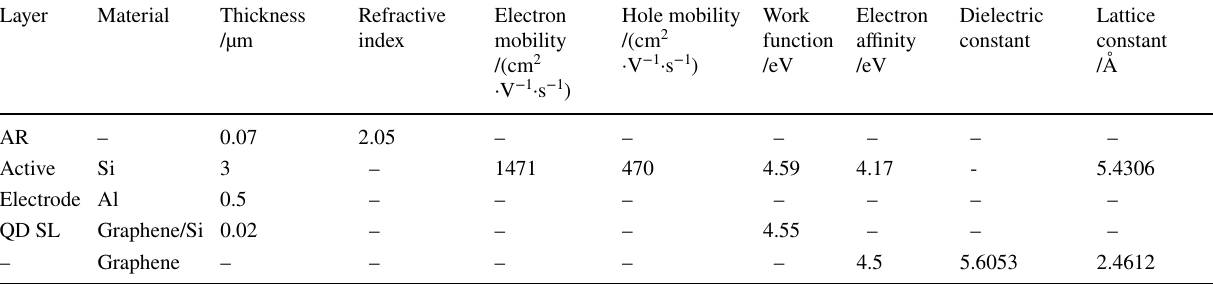
Table 1 Model geometry and material parameters used in the simulation